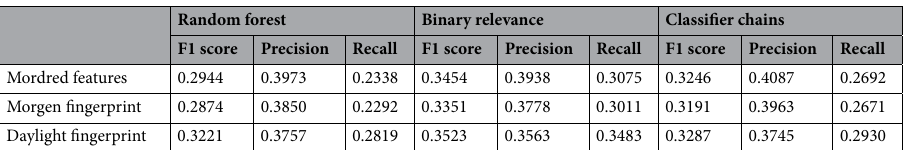
Table 3. Showing micro averaged precision, recall, and F1 test scores for each featurization and model approach.